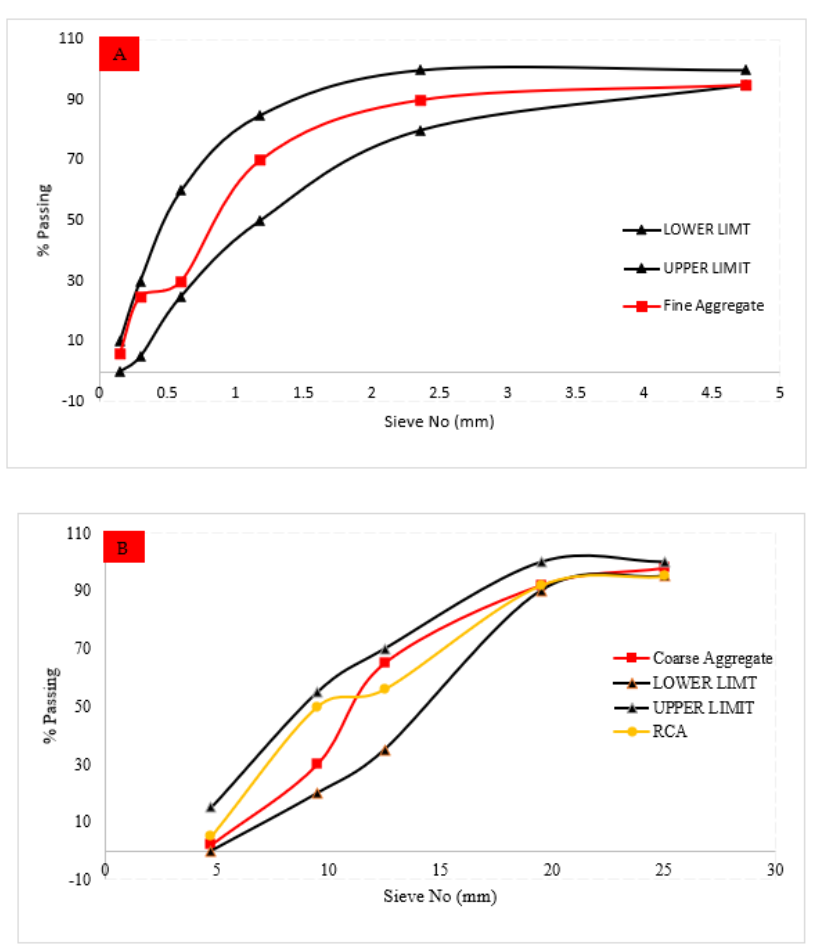
Figure 2. Particle size distribution curve of ( A ) fine aggregate and ( B ) coarse aggregate.